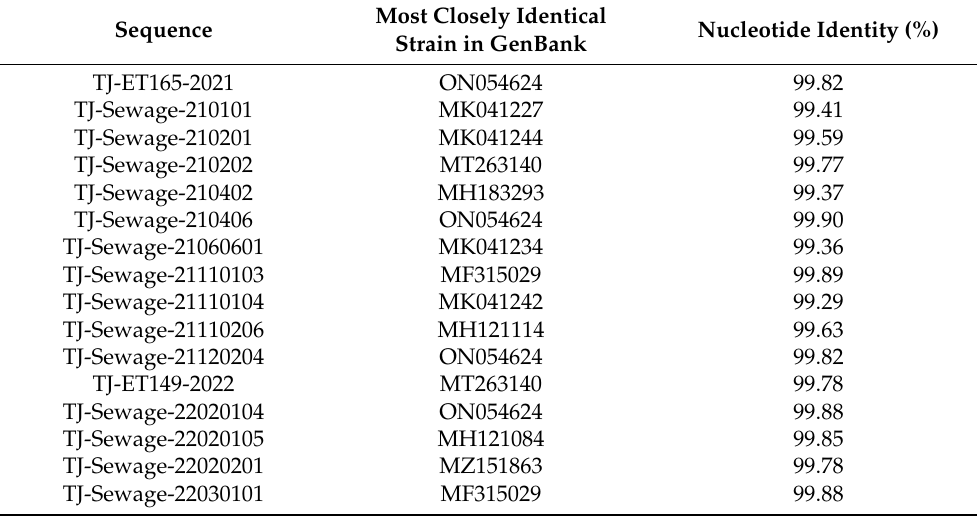
Table 3. The most closely identical strains in the GenBank and their nucleotide identity with 16 Tianjin strains. Most Closely Sequence